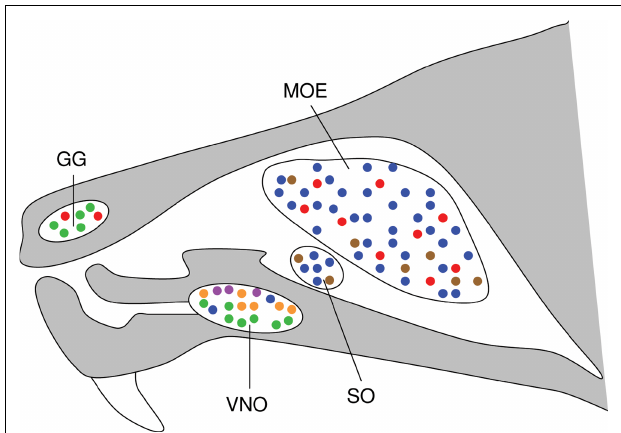
FIGURE 1 | Different olfactory compartments in the nose express distinct types of olfactory receptors. Schematic representation of the murine nose and its olfactory subsystems, including the main olfactory epithelium (MOE), the vomeronasal organ (VNO), the septal organ (SO), and the Grueneberg ganglion (GG). The olfactory receptor types expressed in each of these organs are indicated by color: ORs in blue, V1Rs in orange, V2Rs in green, TAARs in red, FPRs in purple, GC-D in brown (modifi ed from Fleischer et al., 2007).